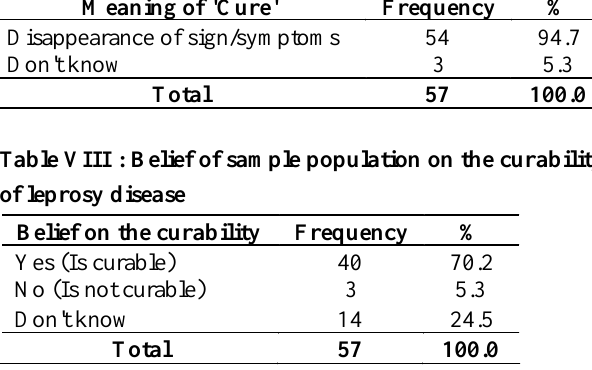
Table IX : Duration of treatment as known to